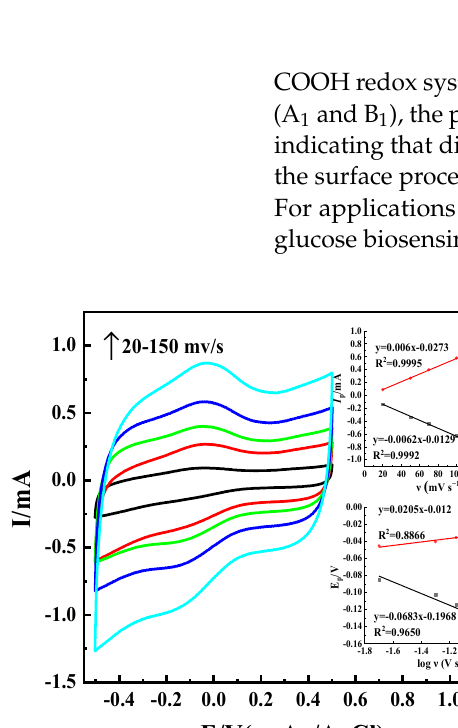
e f ( C ) Figure 7. CVs (50 mV·s − 1 ) of Nafion/OMC-COOH ( A ), Nafion/GOx/OMC-COOH ( B ), and Nafion/GOx-NH 2 /OMC- COOH ( C ) in air-saturated PBS 0.1 M pH 7.4 without (a,c,e, respectively)/with (b,d,f, respectively) the addition of 20 mM